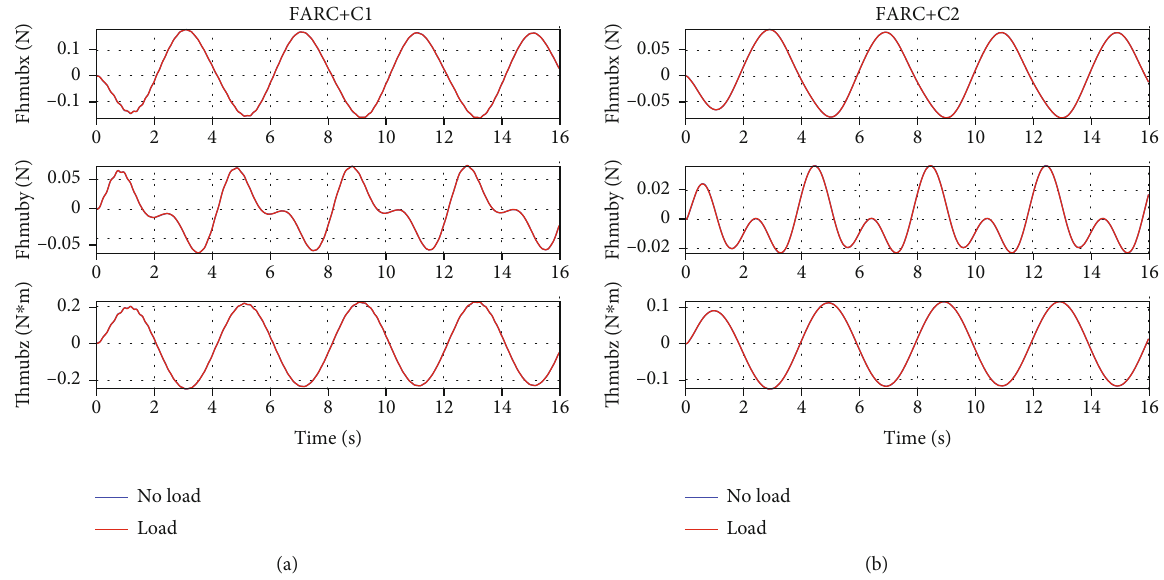
Figure 10: Human-machine interaction force of double leg support for Set3: (a) at the back for FARC+C1 and (b) at the back for